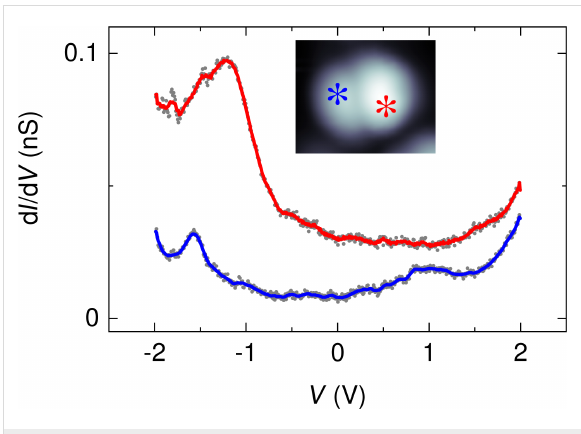
Figure 3: Spectra of d I /d V (dots) recorded above the different lobes of C 42 H 28 on Pt(111) (feedback loop parameters prior to spectroscopy: 2.5 V, 100 pA). The solid lines represent smoothed data. The bottom (top) spectrum was acquired atop the left (right) lobe of the molecule as indicated in the inset. Inset: STM image of a single C 42 H 28 mole- cule on Pt(111) (1 V, 100 pA, 3 × 2.5 nm 2 ) with asterisks marking the positions of